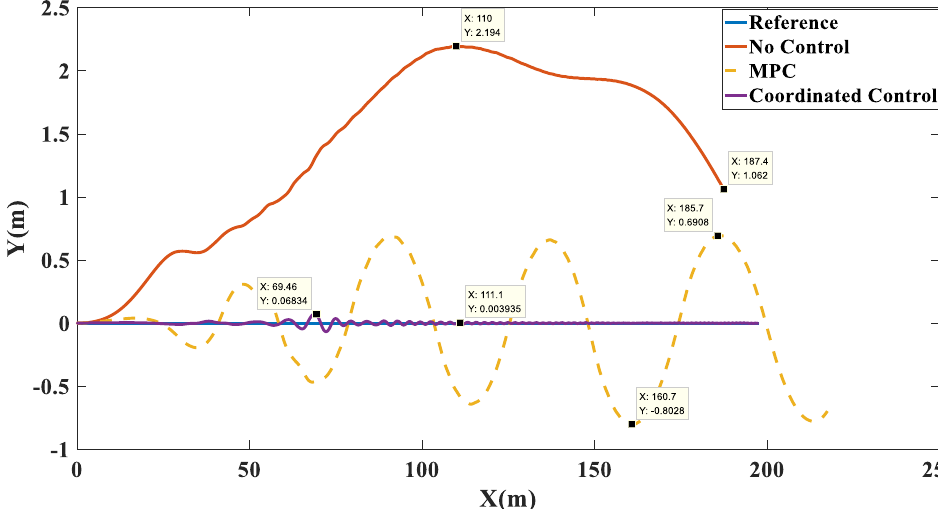
Figure 17. Path tracking comparison chart on the sine sweep straight